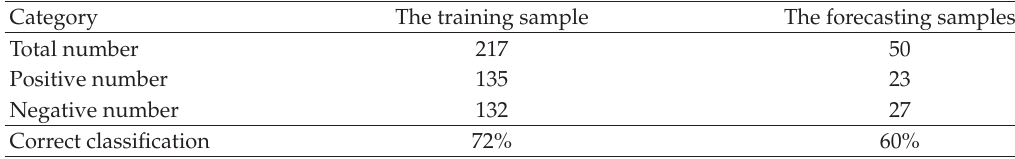
Figure 1: Predicting results of USD/EUR. Table 1: Accuracy rate with di ff erent parameters.